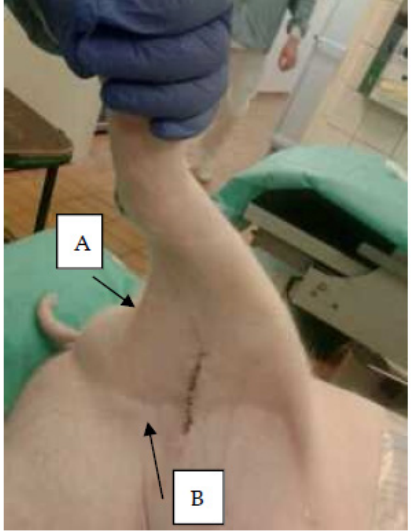
Figure 1. Lymph nodes. Photo of right hind limb of a juvenile pig. Arrows indicate positions of A, right popliteal; and B, right mammary lymph nodes. The medial iliac lymph nodes (right and left) are located within the abdominal cavity on the surface of the iliac bones (Figure 2).